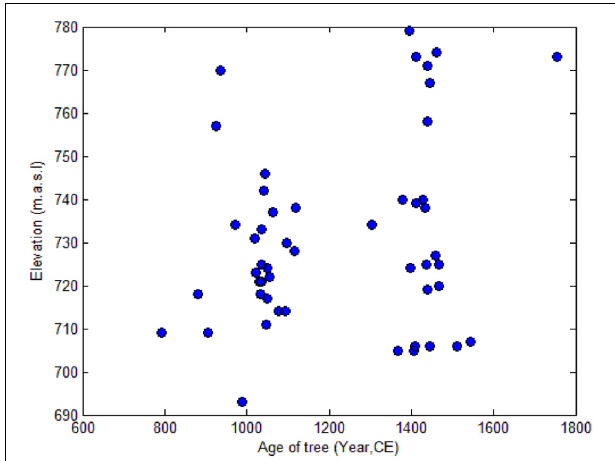
FIGURE 4 | Scatter plot of the elevation of each individual tree and its growing period of the tree in Håckervalen. Note that not all 79 drywood trees are plotted in this